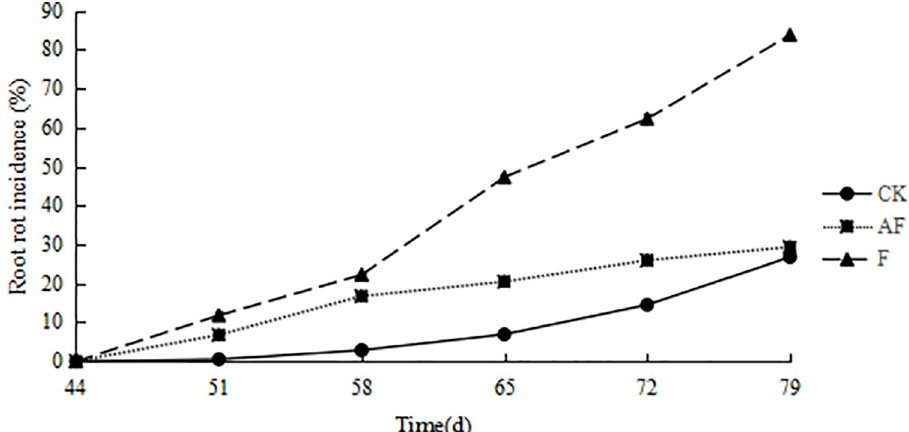
Fig 2. Root rot incidence. CK, control group; AF, soybean planted in continuously cropped soil inoculated at 44 d after sowing and evenly mixed with F . mosseae ; F, soybean planted in continuously cropped soil inoculated with F . oxysporum at 44 d after sowing. The numbers 44, 51, 58, 65, 72 and 79 represent the days after sowing. The x-axis means different stages. The y-axis represents the soybean root rot incidence.